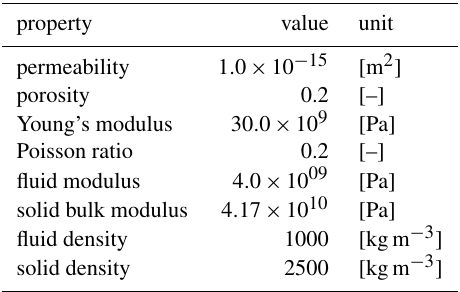
Table 1. Material properties of the rock matrix used for the numer- ical